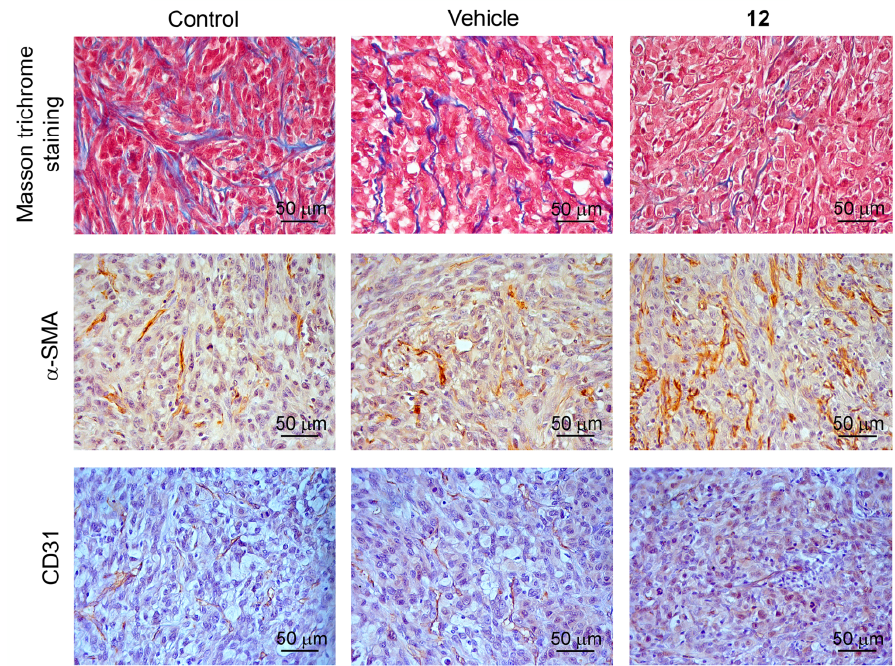
Figure 9. The effect of 12 on collagen fiber content and blood vessel maturity in the subcutaneous U87 glioblastoma xenograft model. Representative histochemical and immunohistochemical images of U87 glioblastoma tissue without treatment and after 12 or vehicle administration stained with Masson’s trichrome ( upper panel ) and primary antibodies to α-SMA and CD31 ( middle panel and bottom panel , respectively). Original magnification ×400.